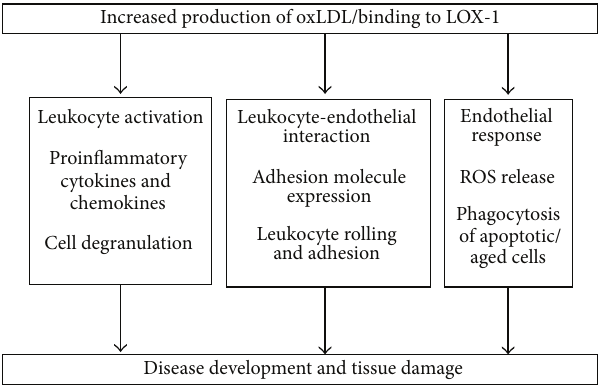
Figure 1: Schematic presentation of selected cellular effects of oxidized LDL (oxLDL) and/or Lectin-like oxLDL receptor (LOX-1) activation in systemic